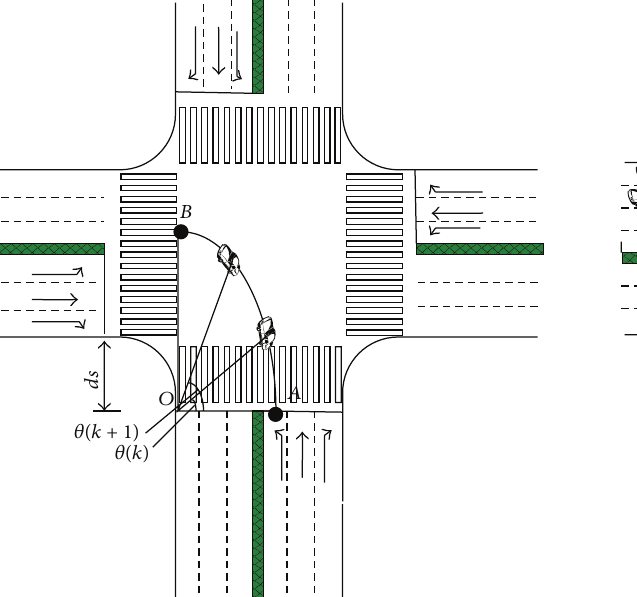
Figure 5: Left-turning vehicle’s trajectory diagram.